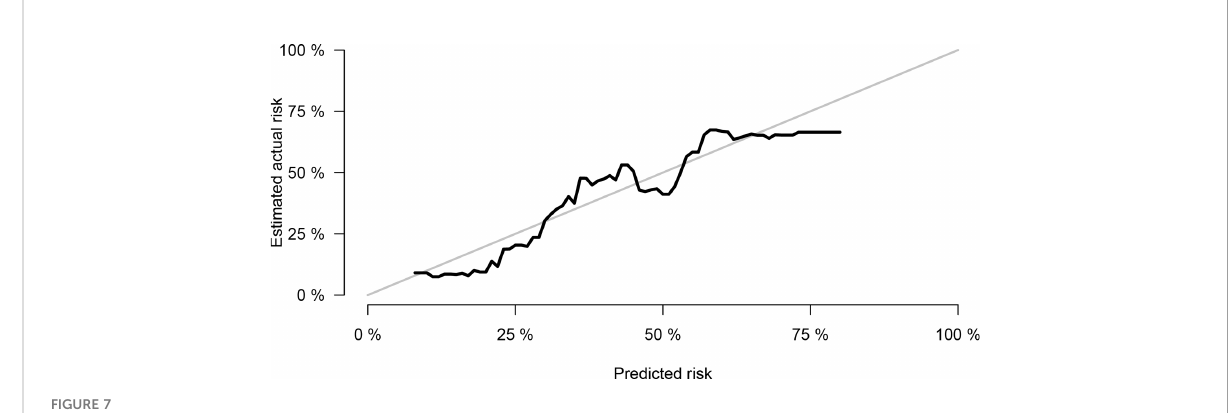
FIGURE 7 Decision curve analysis of Cox